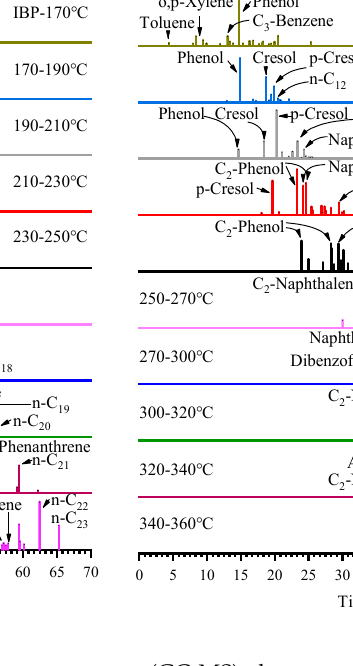
Figure 4. Gas chromatography-mass spectrometer (GC-MS) chromatograms of narrow distillate fractions. ( a ) The main components of narrow fractions from MLCT-Z; ( b ) The main components of narrow fractions from MLCT-S.